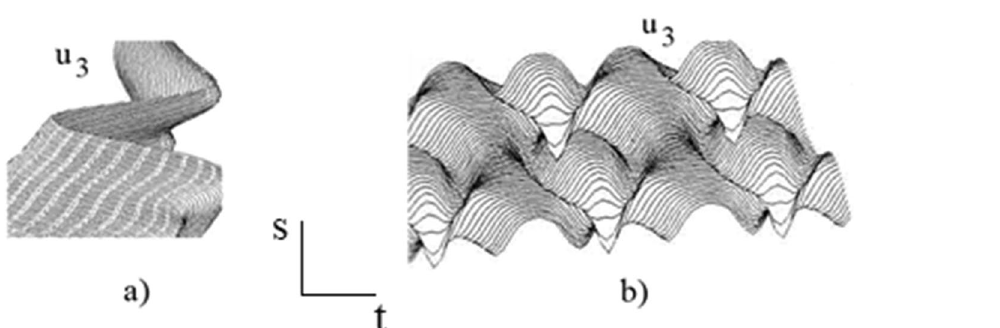
Figure 6. Function u 3 for ( a ) the first route and ( b ) the second